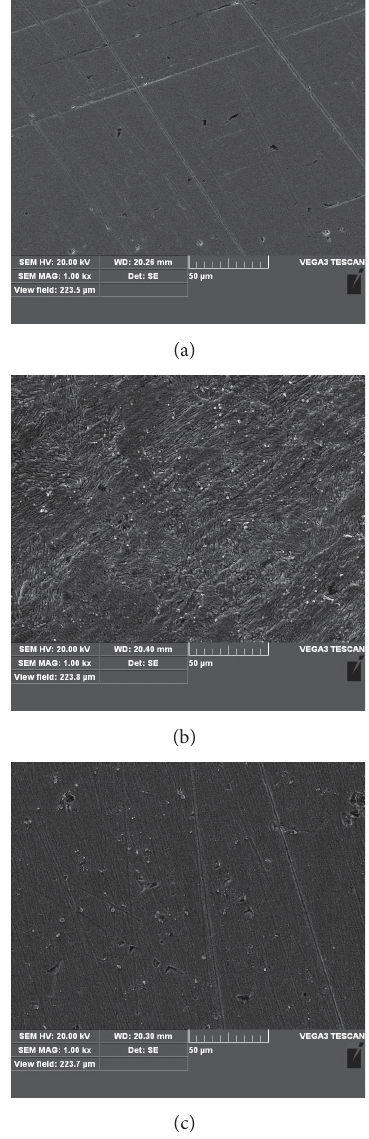
Figure 9: SEM micrographs for the carbon steel surface: before corrosion (a), after immersion in 0.5 MHCl without EAPP (b), and with 160mg L −1 EAPP (c) at 300 K for